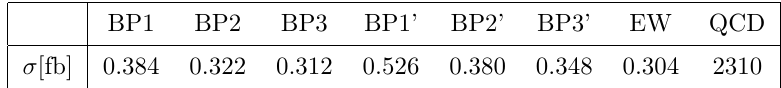
Table 3 . Predictions after jets reconstruction for the cross sections, (cid:27) ( pp ! JJjj ) in fb, cor- responding to the signal points, BP1, BP2, BP3, BP1’, BP2’ and, BP3’, and for the main backgrounds: SM-EW (EW) and SM-QCD (QCD). The results are generated with Mad- Graph+PYTHIA+DELPHES, summed over the interval 800 GeV < M JJ < 3000 GeV, and